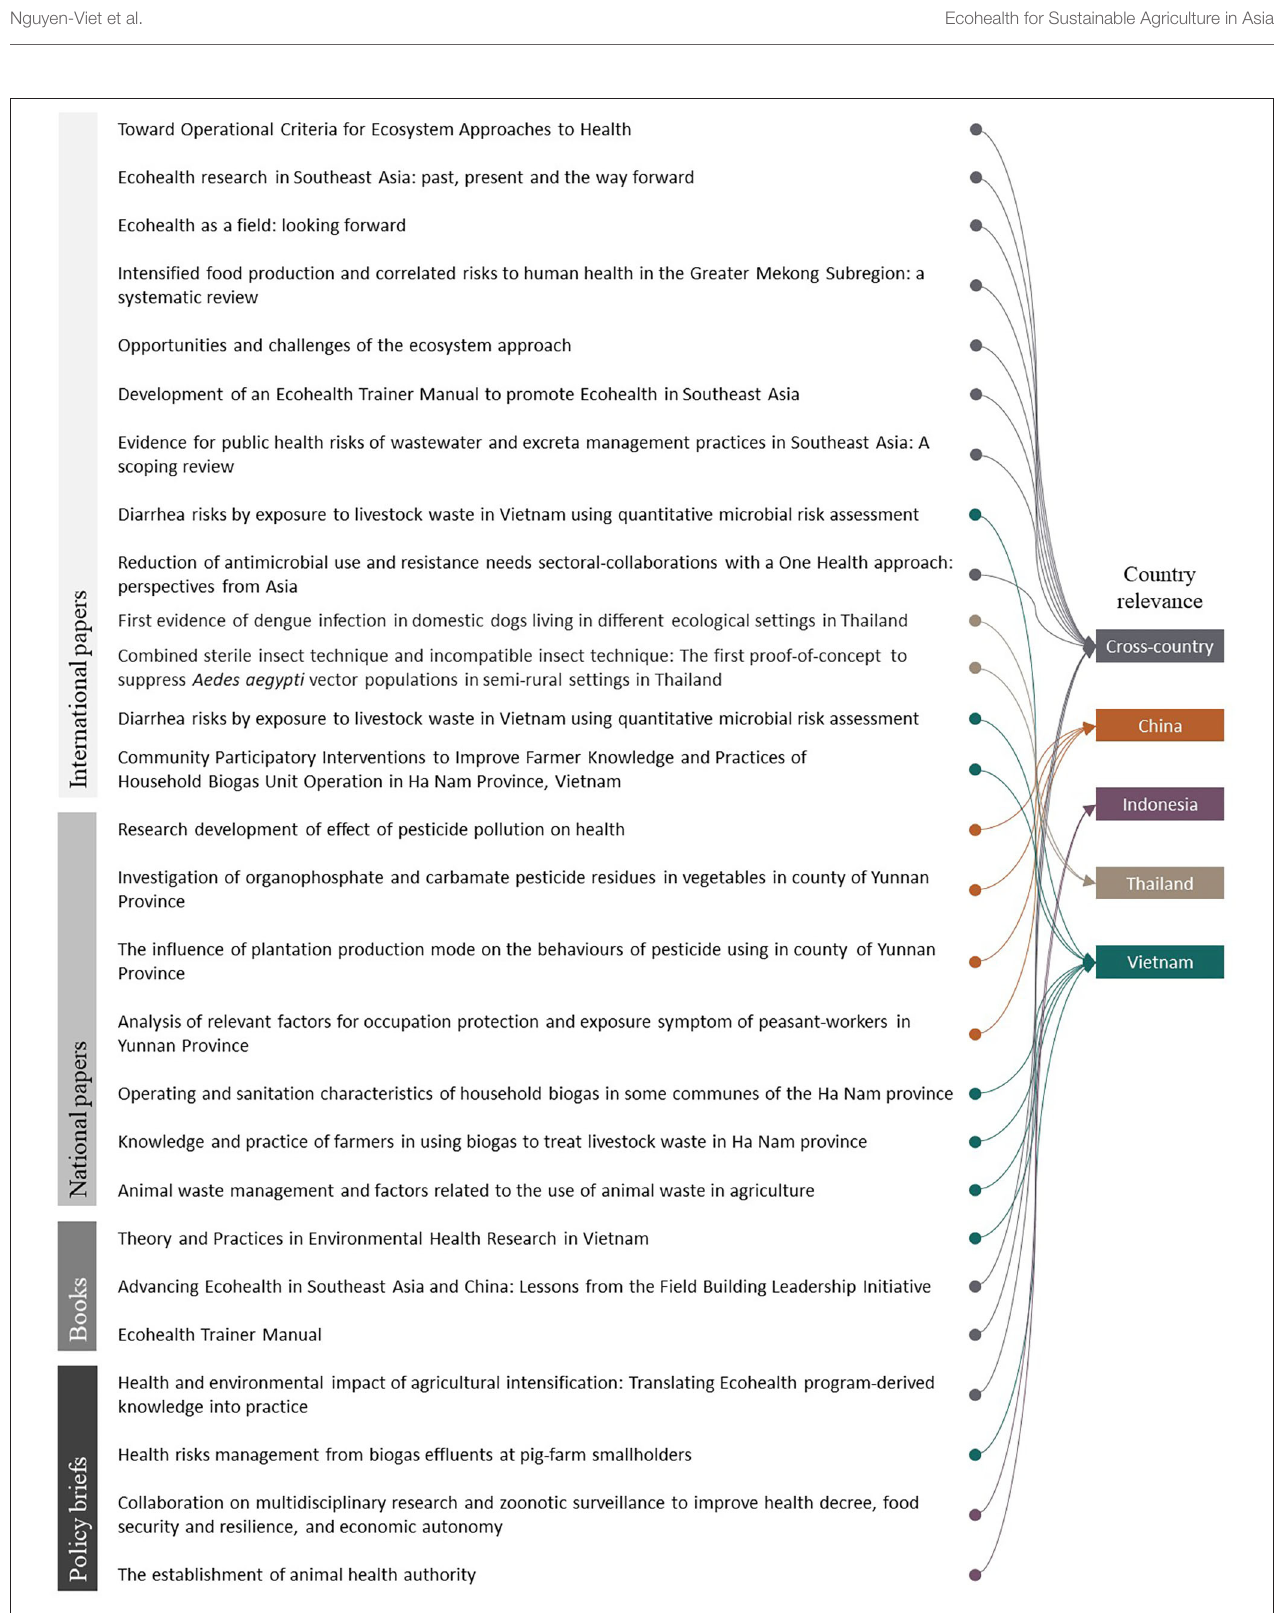
FIGURE 2 | Publications from Ecohealth projects in China, Indonesia, Thailand, and Vietnam.